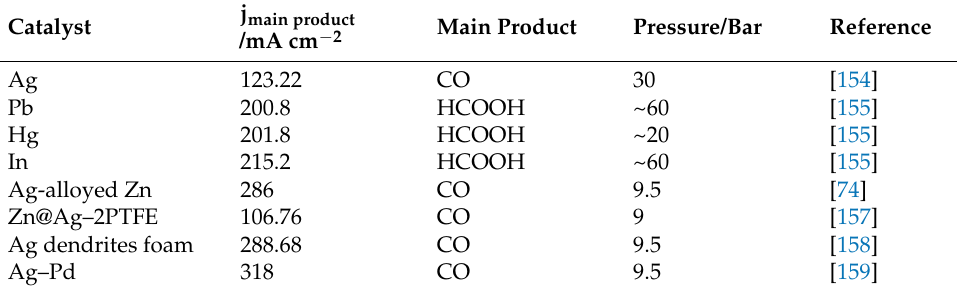
Table 8. CO 2 electroreduction performances under high